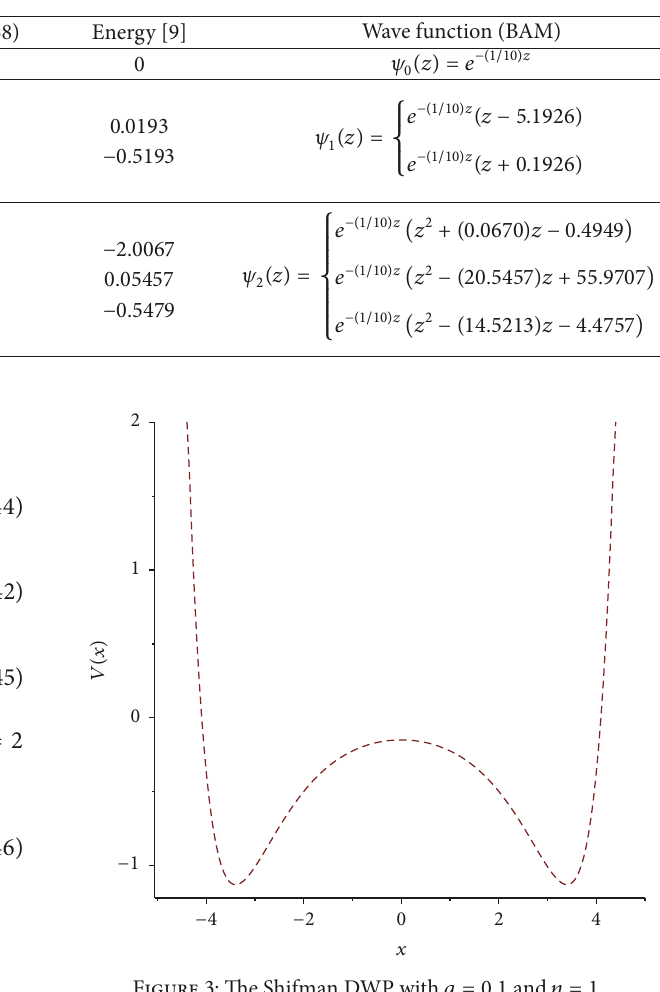
Table 4: Solutions of the first three states for the Shifman DWP with 𝑎 = 0.1 , where 𝑧 = cosh (𝑥) .